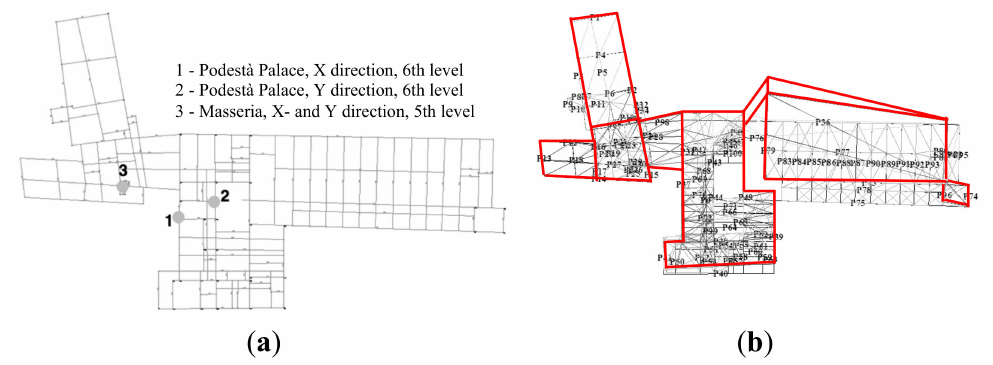
Figure 10. ( a ) Control nodes’ definition; ( b ) deformed shape in plan of the whole complex in the +Y-direction (scale factor equal to